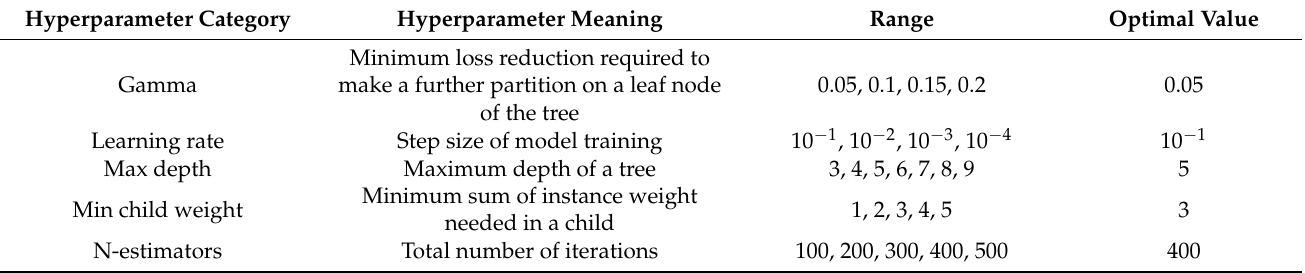
Table 5. Optimized hyperparameter types, meanings, ranges and optimal values of XGBoost.